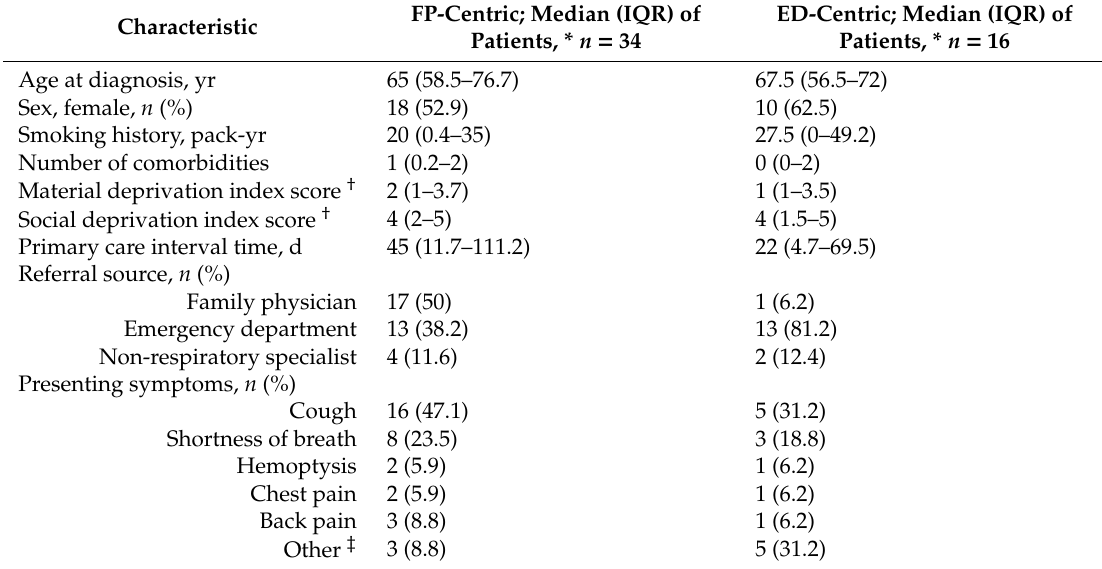
Table 3. Characteristics of patients stratified by FP-centric and ED-centric